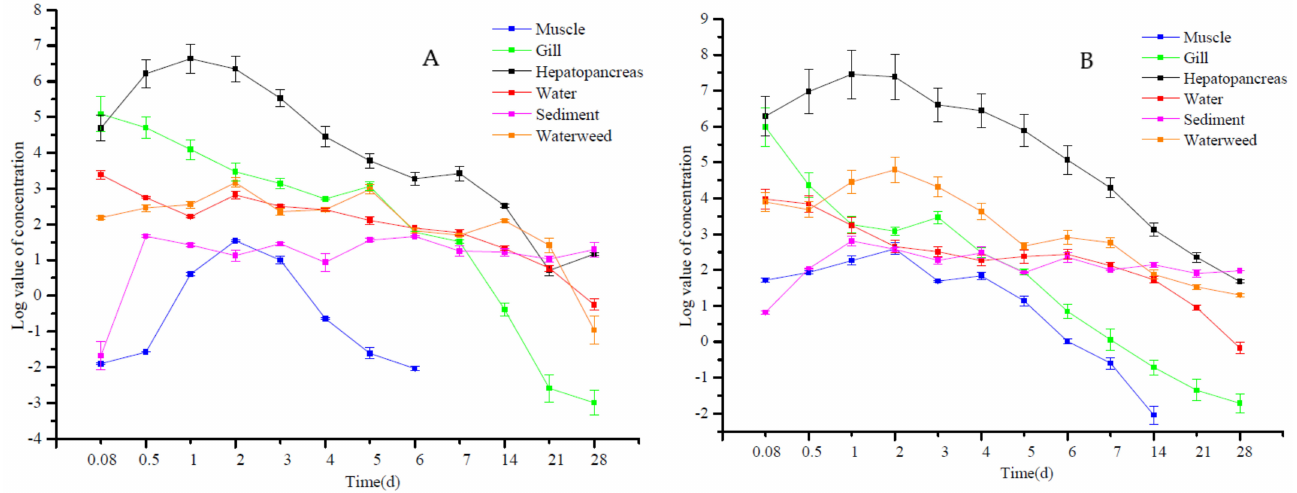
Figure 2. Log values for pendimethalin concentrations in the indicated tissues sprayed on outdoor test ponds at ( A ) 0.27 and ( B ) 0.14